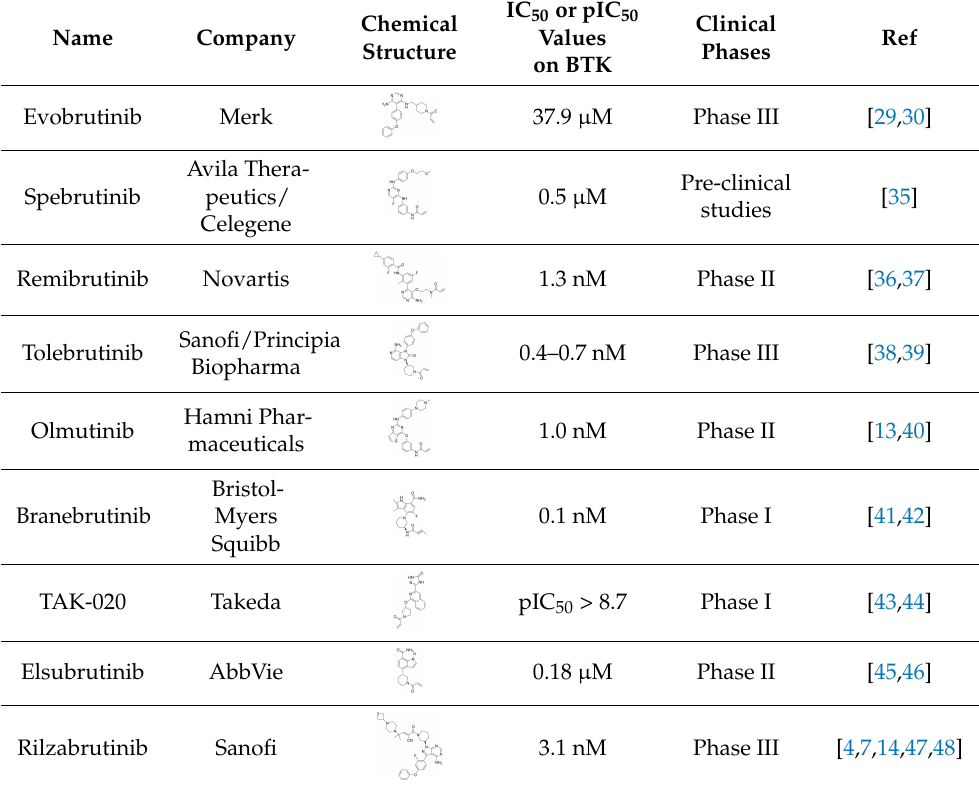
Table 2. Name, chemical structure, IC 50 values of BTK and clinical phases of irreversible BTKIs under clinical and pre-clinical